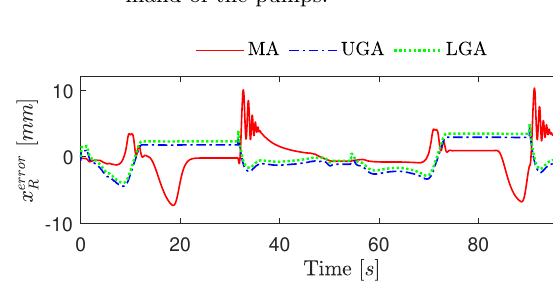
Figure 30: Reach arms position error using